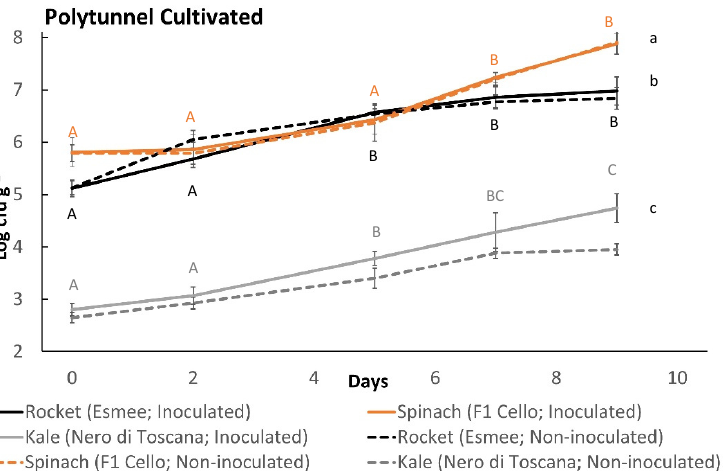
Figure 5. TBCs of experimental farm polytunnel produce: rocket (Esmee, black line), spinach (F1 Cello, brown line), and kale (Nero di Toscana, grey line). Incubated at 7 °C for (6 days) followed by 12 °C (3 days). (±) error bars indicate standard deviation. Solid lines represent produce which has been initially inoculated with 100 cfu g - 1 of L. monocytogenes , dashed lines represent test units that have not been initially inoculated. Letters a–c indicate significant differences in L. monocytogenes growth on inoculated produce; letters A–C indicate significant difference over time in batches inoculated with L. monocytogenes for rocket (black), spinach (brown), and kale (grey).